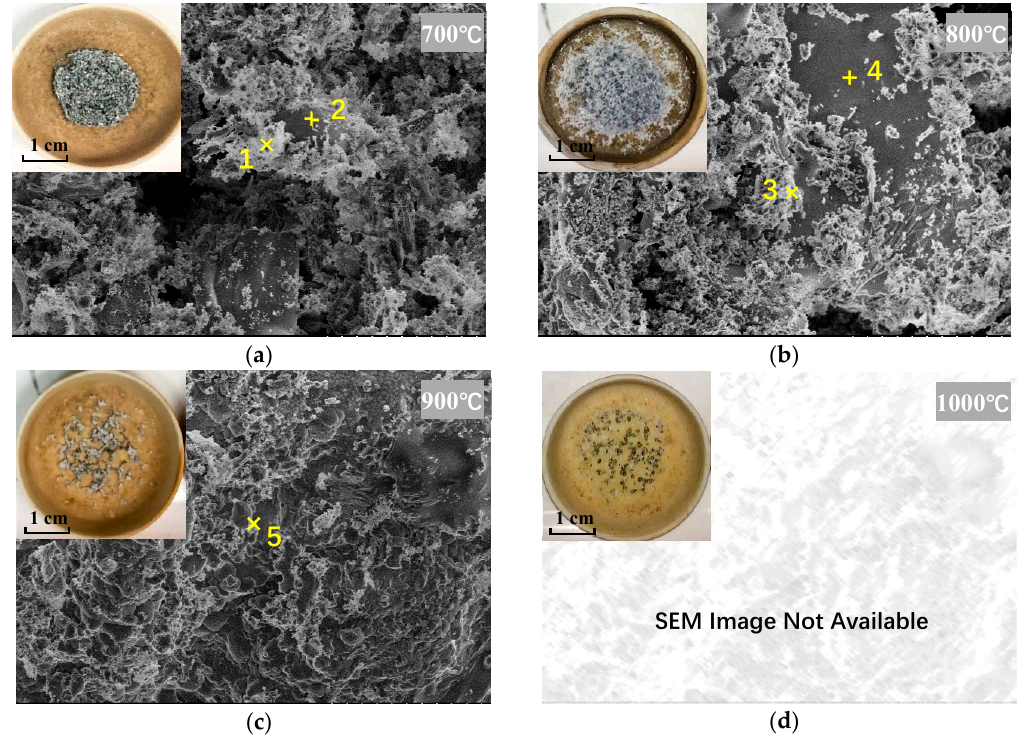
Energies 2019 , 1 9 primarily pale in color, with a small amount of ash forming a hard and dense precipitate, which was different than that of WS GO . Un-sintered particles (Point 11 in Figure 4d) with a similar microstructure Figure 3. SEM images of WS GO ashes: ( a ) WS GO ash heated to 700°C, ( b ) WS GO ash heated to 800°C, ( c ) Figure 3. SEM images of WS GO ashes: ( a ) WS GO ash heated to 700 ◦ C, ( b ) WS GO ash heated to 800 ◦ C, to that of Point 5 in Figure 4c were observed under SEM. Melted particles existed in WS GL , although, WS GO ash heated to 900°C, and ( d ) WS GO ash heated to 1000°C (SEM image was not available). ( c ) WS GO ash heated to 900 ◦ C, and ( d ) WS GO ash heated to 1000 ◦ C (SEM image was not available). unlike in WS GO , the leaching process had already decreased the risk of sintering at 1000 °C.